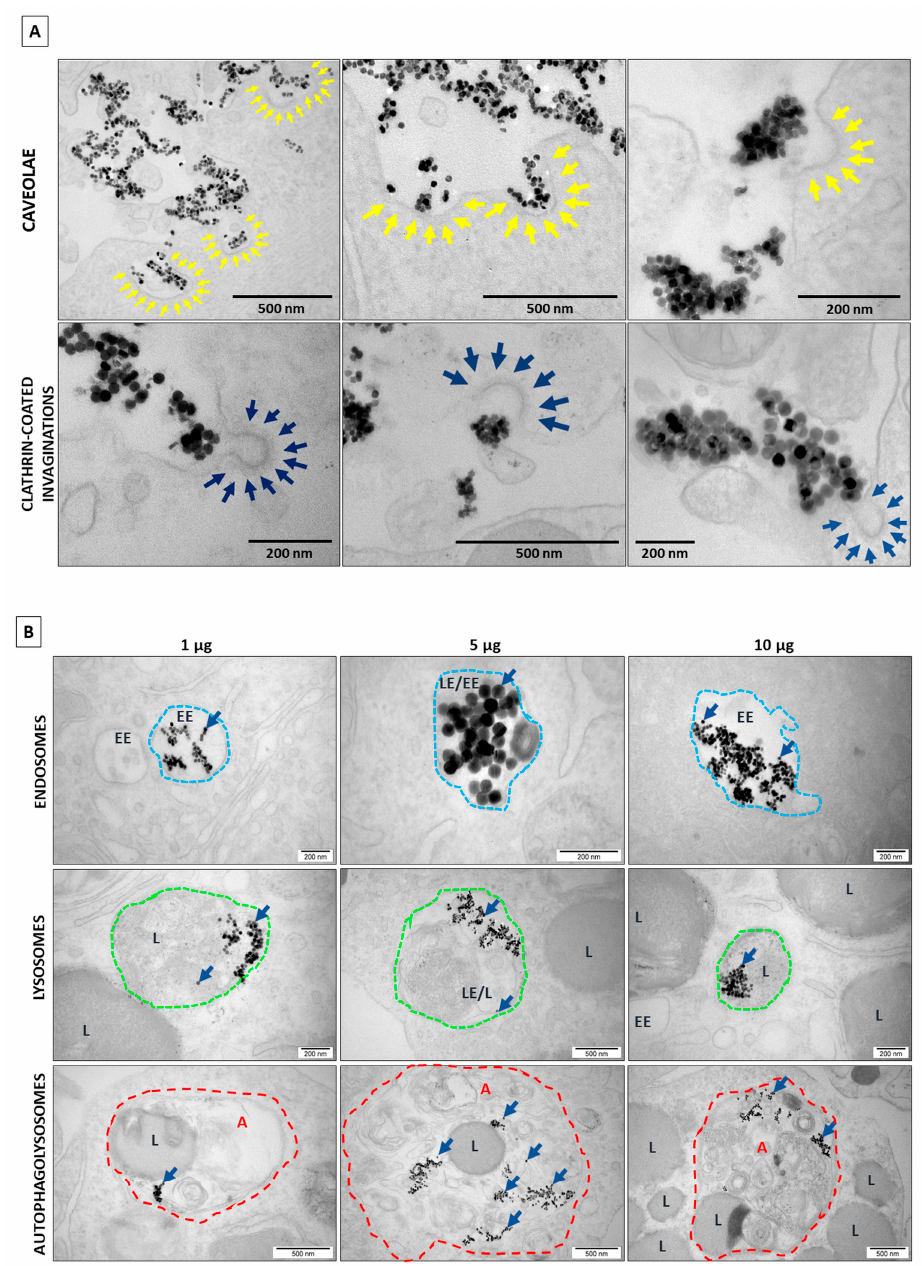
Figure 4. ( A ) The formation of the caveolae (marked with yellow arrows) and clathrin-coated vesicles (marked with dark blue arrows) at the cell membrane in the presence of UCNPs after 2 h of incubation (a droplet contains 1 µ g of UCNPs). ( B ) The co-localization of UCNPs (marked with dark blue arrows) with various intracellular structures. UCNPs are administered in a droplet on the top of the slice after 2 h of incubation, enclosed in early endosomes (EE—outlined in blue dashed line), in late endosomes (LE) or lysosomes (L—outlined in green dashed line), in autophagolysosomes (A—outlined in red dashed line).